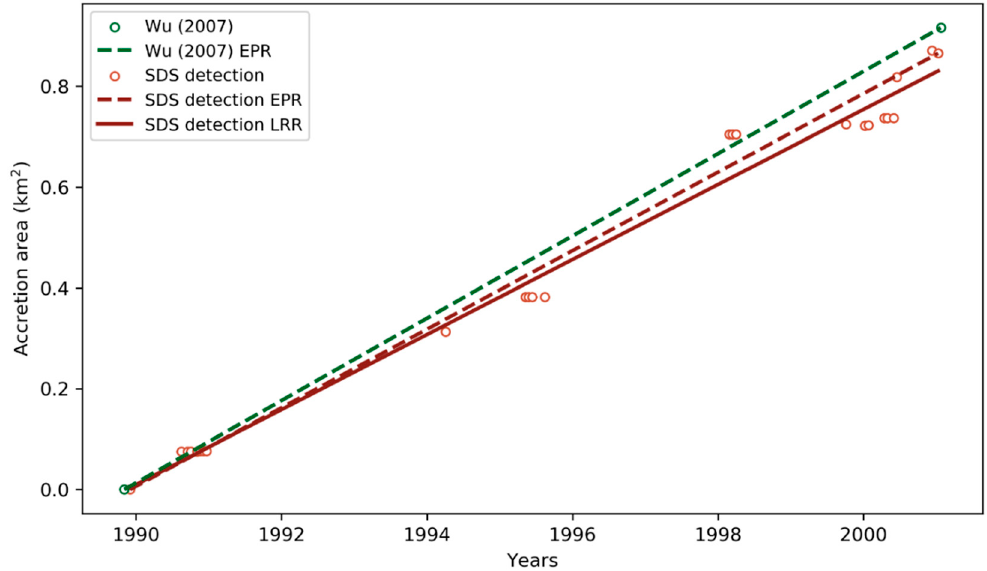
Figure 13. Relative accretion area detection compared to the first analysed image northward of port of Nouakchott in Mauritania based on Wu [9] (in green) and our study (in red). The dots represent the relative accretion areas in time, the dashed lines the trend line based on end point rate (EPR) and the solid line the linear regression rate (LRR).